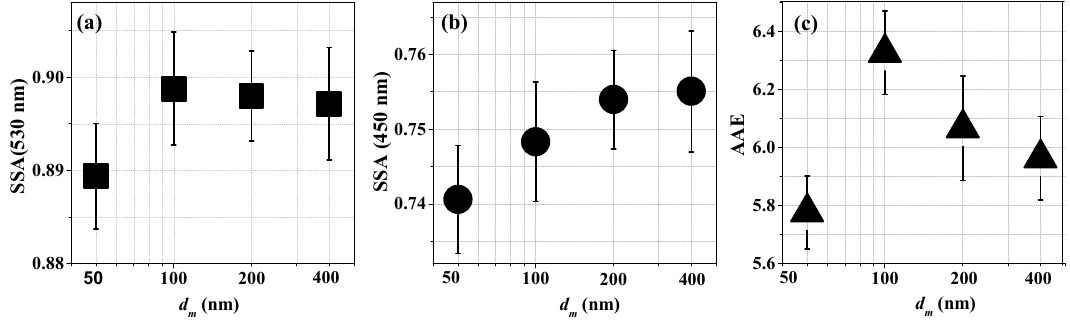
Figure 4. (a–b) Size-resolved single-scattering albedo (SSA) at wavelengths of 530 and 450nm. (c) Ångström absorption exponent (AAE) of biomass burning particles at room temperature (20 ◦